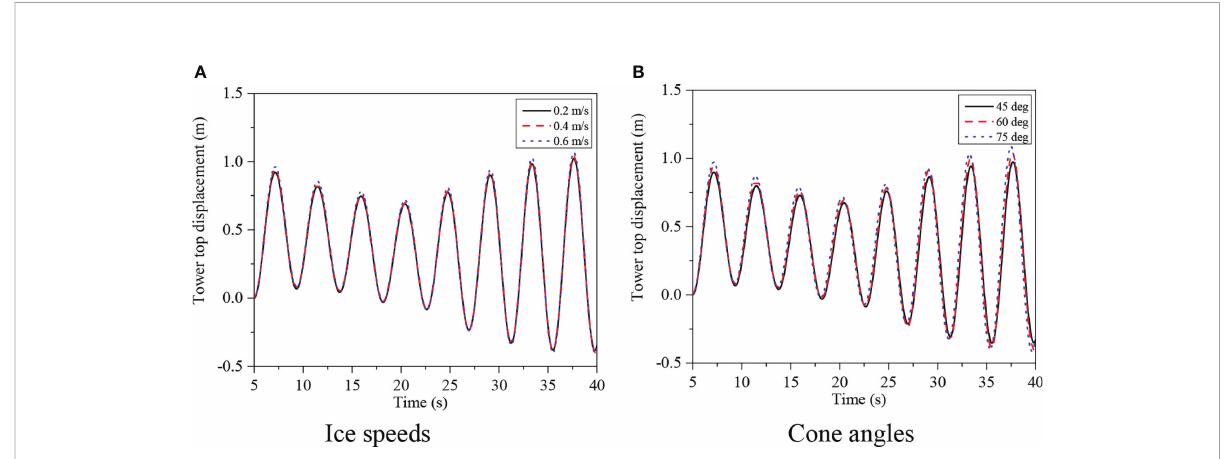
FIGURE 13 Histories of tower top displacements under selected wind-ice cases. (A) Ice speeds (B) Cone